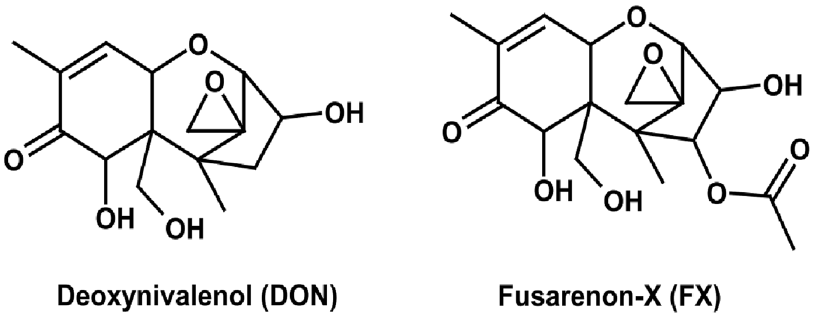
Figure 1. Chemical structures of DON and